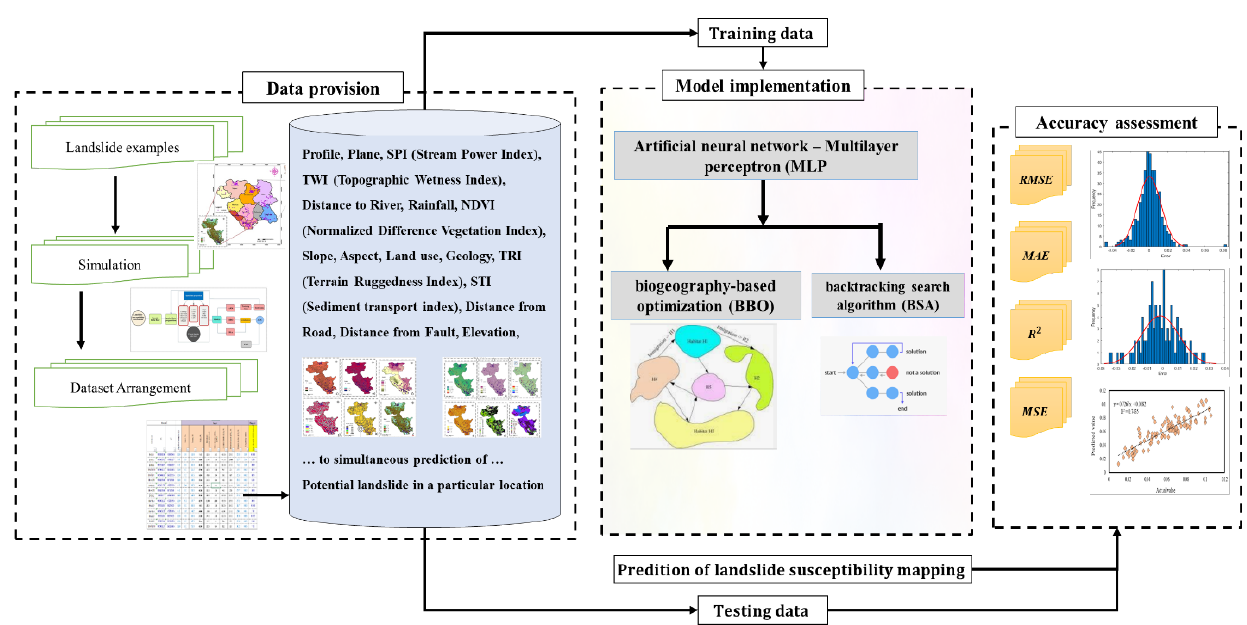
Figure 3. Research flowchart including input parameters to predict the output.